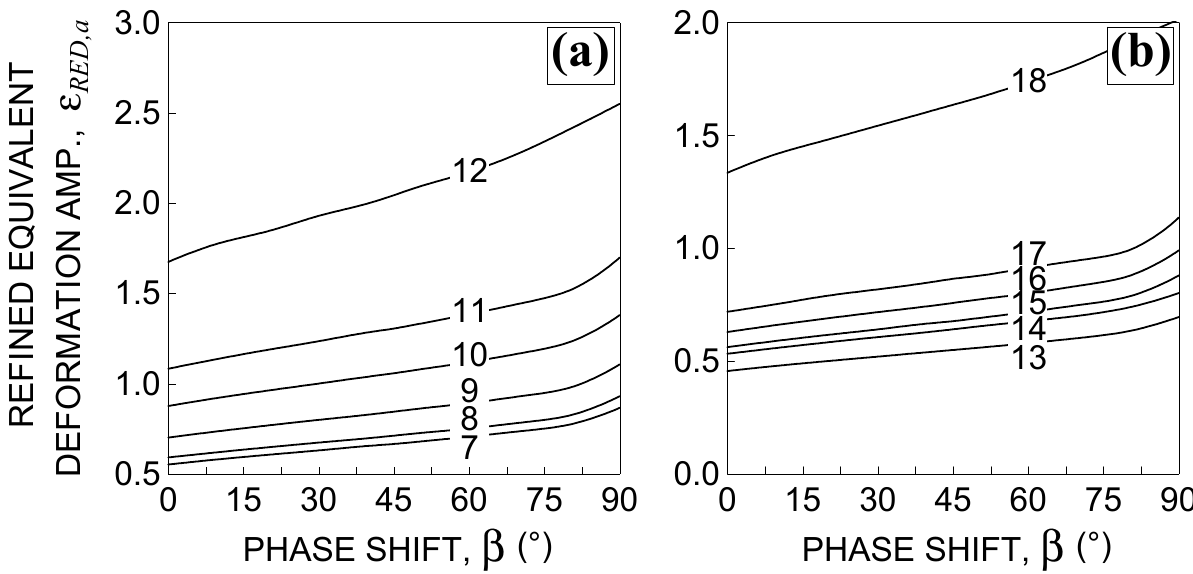
β β ° ≤ ≤ ° Figure 10. Influence of the phase shift ( 0 90 ) on the refined equivalent deformation amplitude for the Figure 10. Influence of the phase shift β ( 0 ◦ ≤ β ≤ 90 ◦ ) on the refined equivalent deformation amplitude for the loading loading conditions: ( a ) Nos.7–12 and ( b ) Nos.13–18, in Table 2. conditions: ( a ) Nos. 7–12 and ( b ) Nos. 13–18, in Table